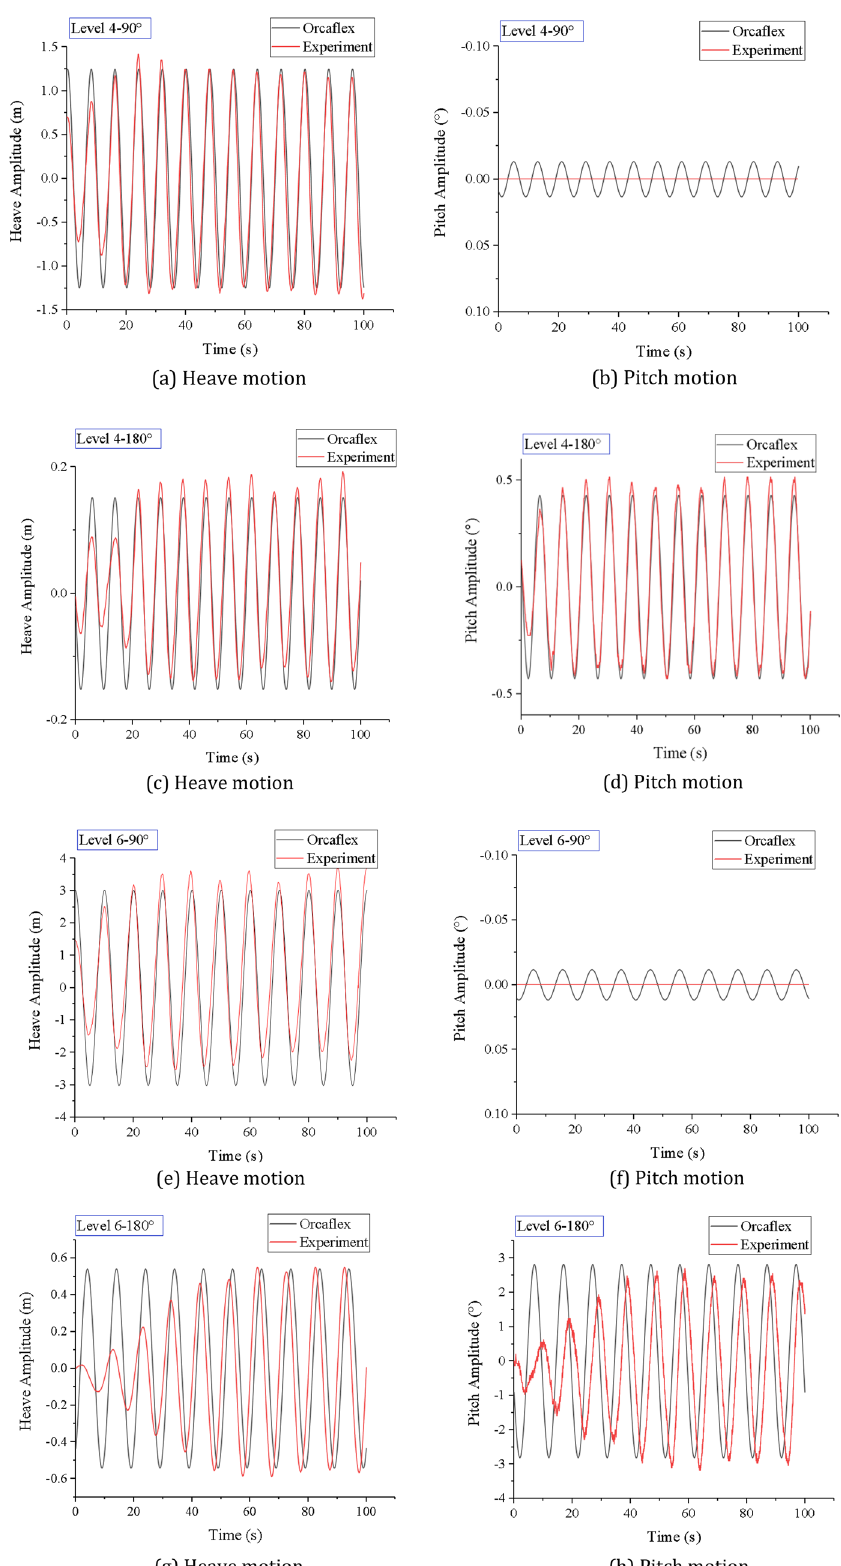
Figure 11. The mining vessel motion at experiment and simulation conditions (created by Origin 2017 software, URL: https:// www. origi nlab.